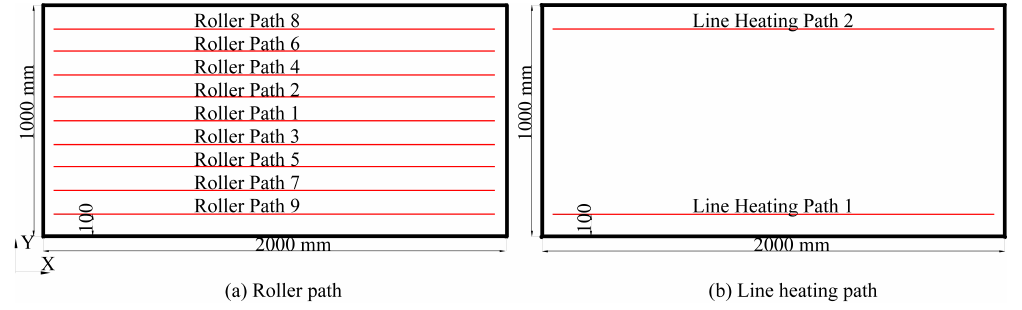
Figure 16. Process line schematic ( a ) roller path ( b ) line heating path.